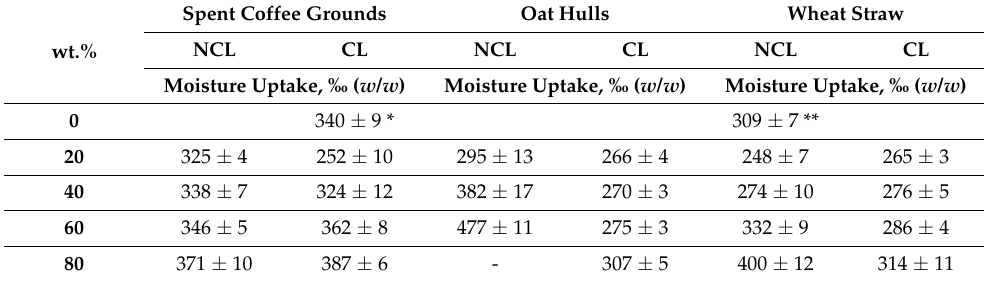
Table 7. Moisture uptake by chitosan-based pellets with (CL) and without crosslinking (NCL) at RH 97%.